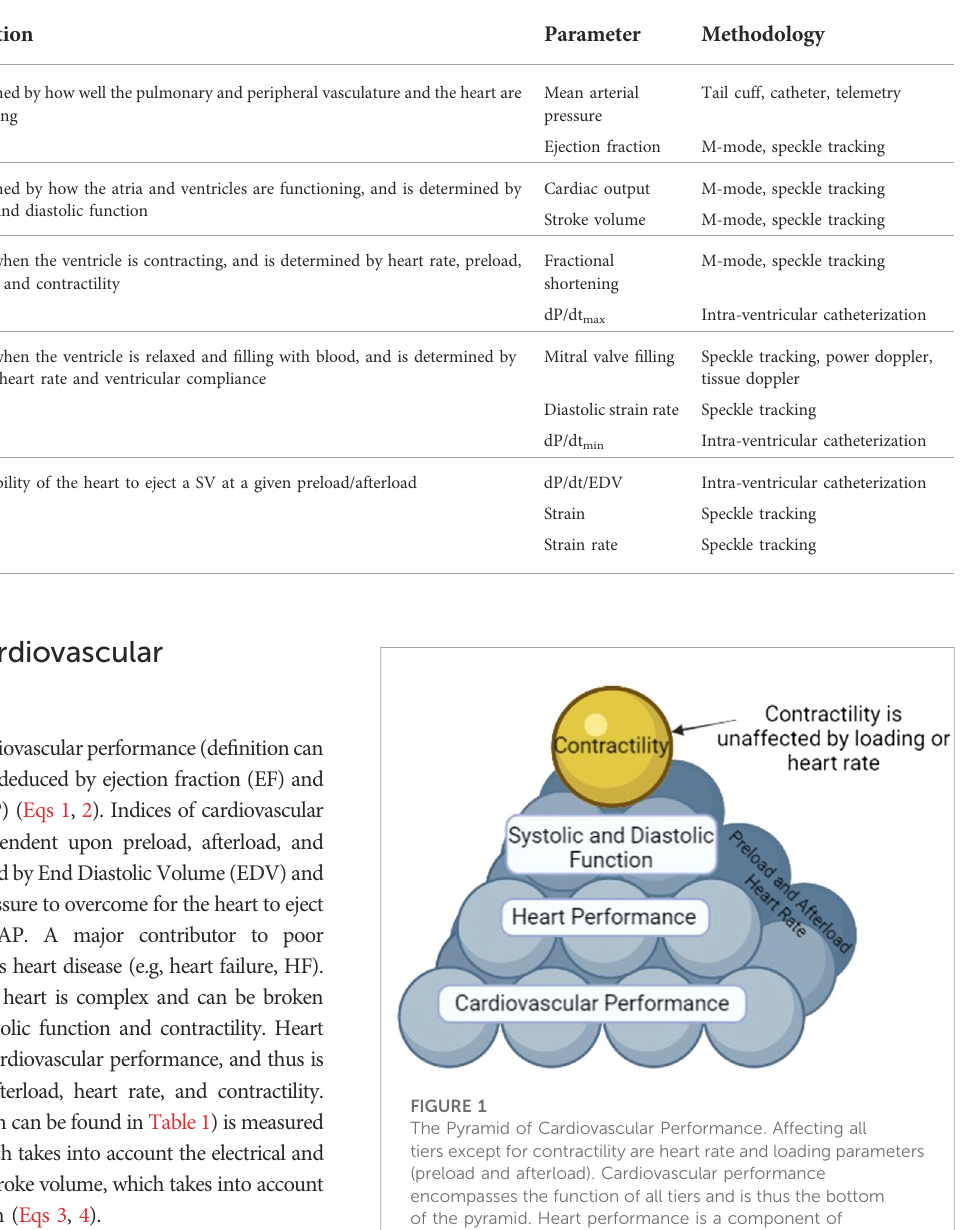
TABLE 1 De fi nitions and measurements of the different tiers.